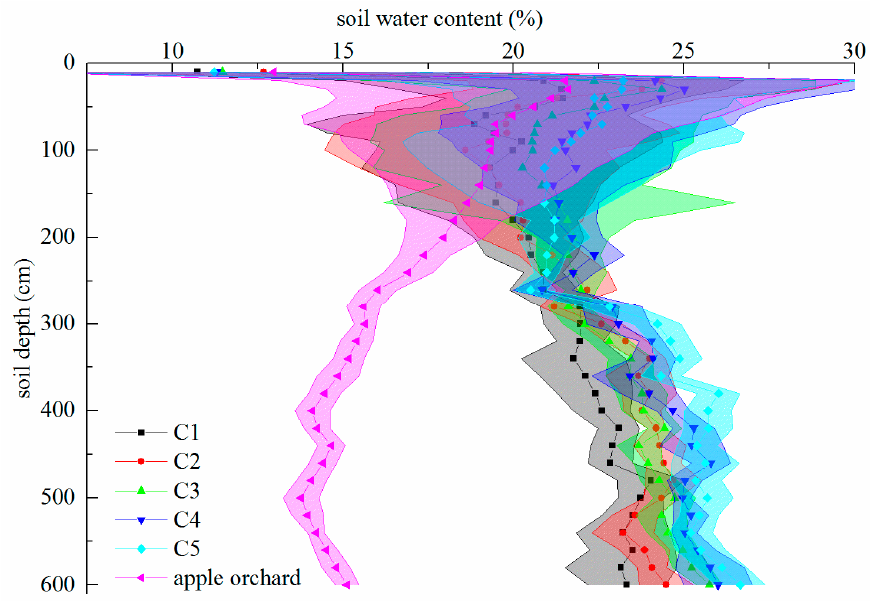
Figure 6. The vertical variations in soil water content at each monitoring site in the cropland. The legend in the figure represents the site of which the soil moisture content is measured.